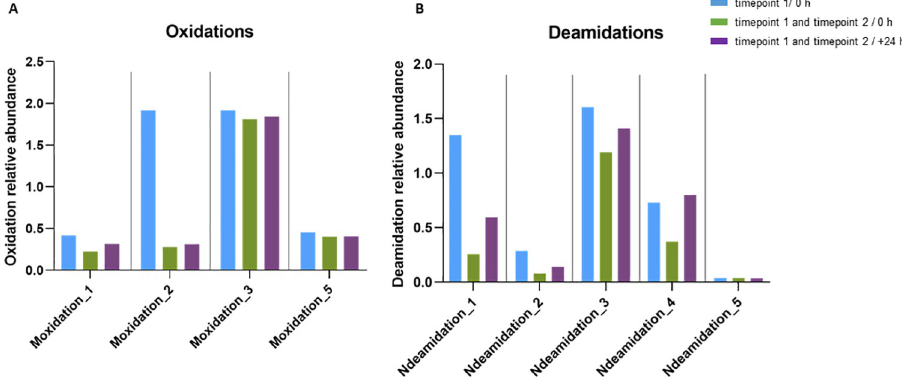
Fig 3. Impact of the addition of 20 mM methionine at two timepoints of the digestion protocol (timepoint 1: Addition at denaturation step and timepoint 2: After buffer exchange) on oxidation and deamination levels at specific sites of the molecule. Samples were analyzed immediately after the sample preparation procedure (0 h, green bars) and again after 24 h (purple bars). For reference, the levels of these PQAs obtained using the protocol with only 1 addition of 20 mM methionine (at the denaturation step, timepoint 1) are also plotted (blue bars).